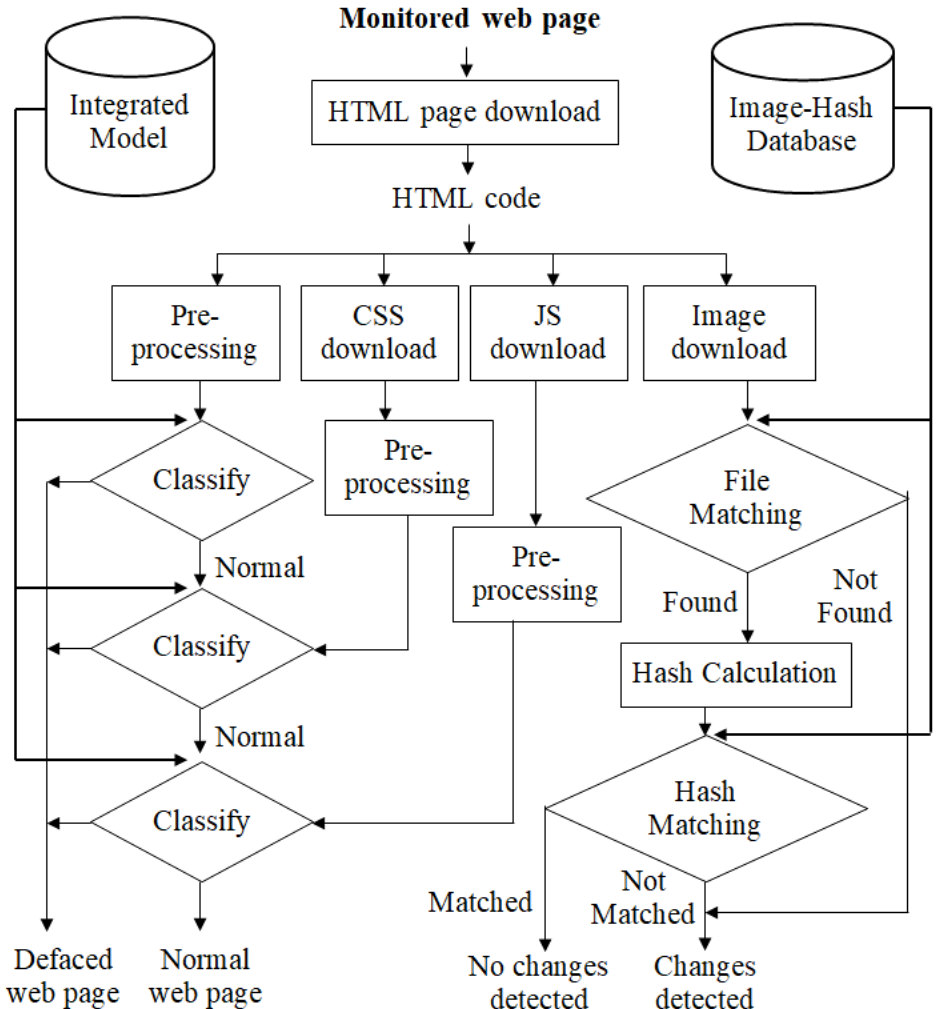
Figure 7. Proposed multi-layer model for website defacement detection: The detection stage